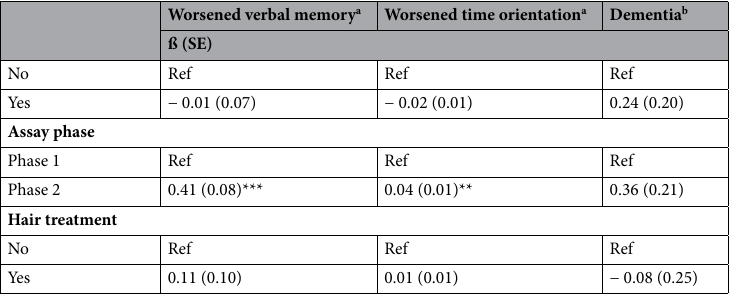
Table 3. Adjusted regression models of hair cortisol as the exposure and cognitive performance and dementia as the outcomes. *P < 0.05, **P < 0.01, ***P < 0.001. a Linear random effect models were used to investigate the associations between hair cortisol and worsened verbal memory and time orientation. b Cox regression model was used to investigate the association between hair cortisol and dementia. c Age and depression score were treated as continuous